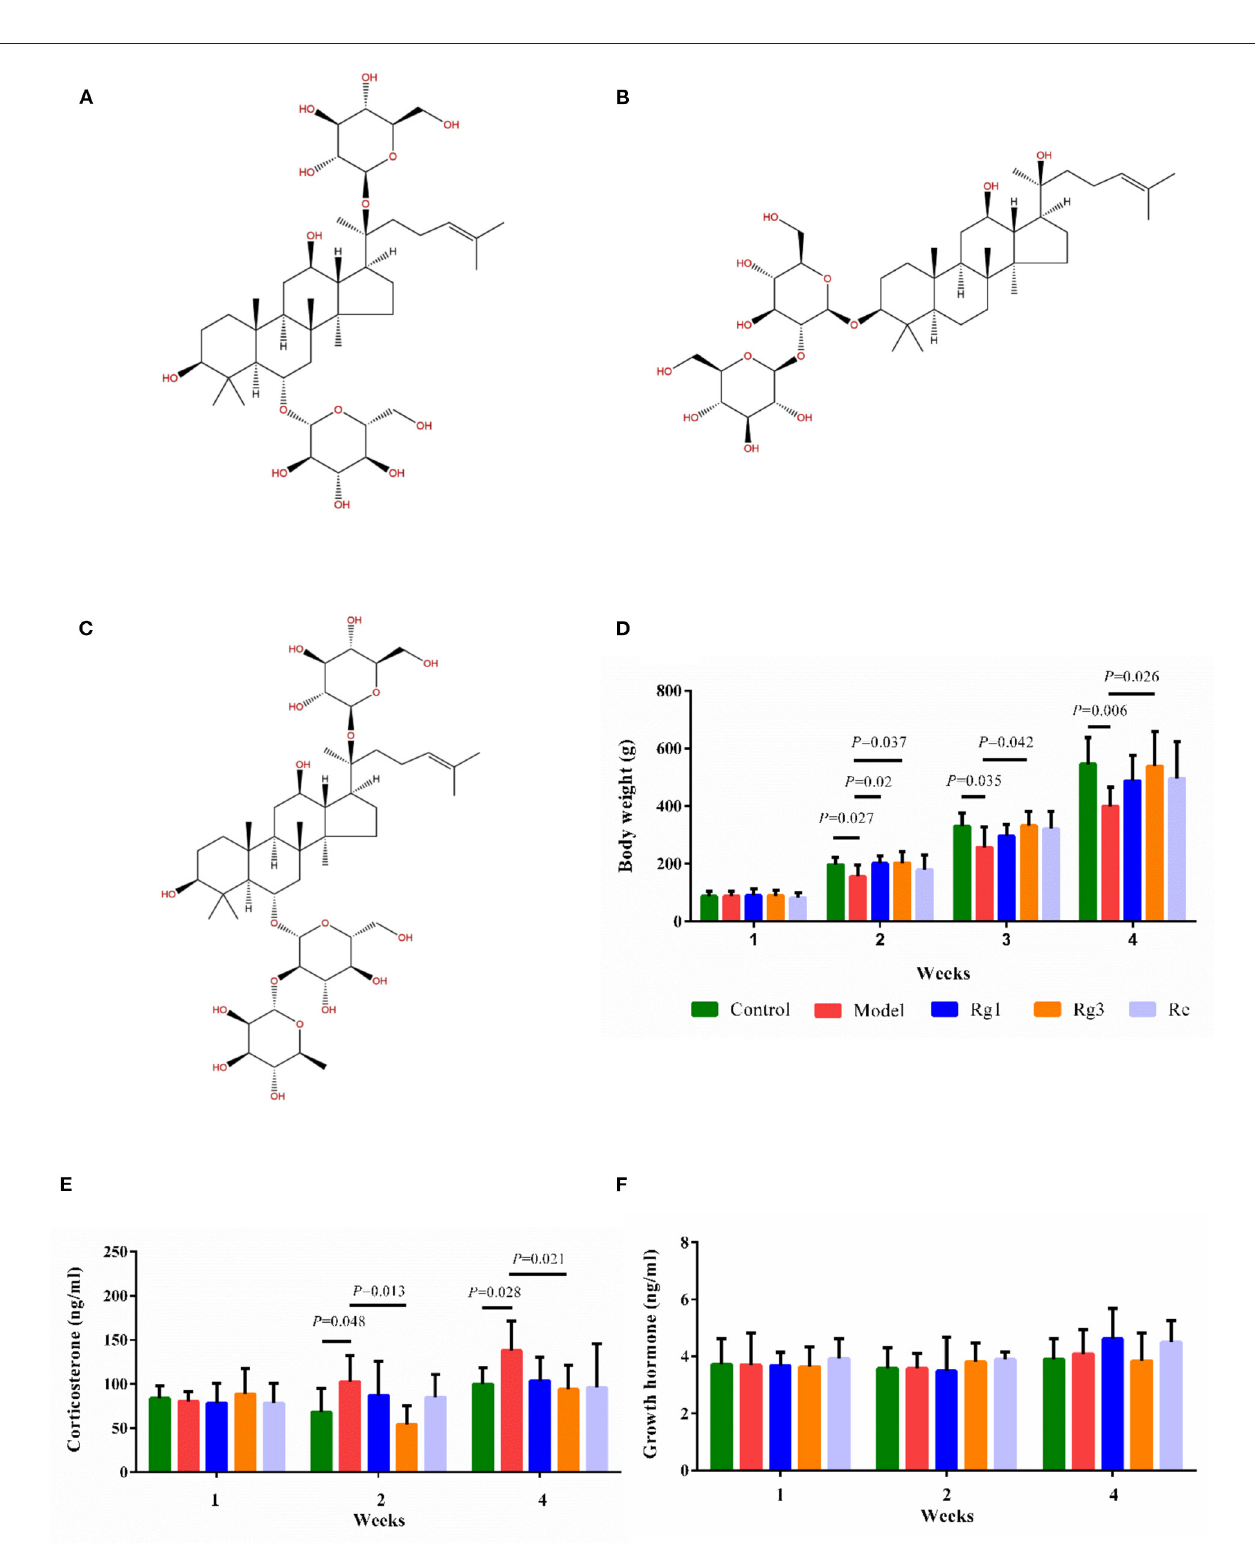
FIGURE 1 | Effect of ginsenosides on growth and stress of broiler chicks. Chemical structure of ginsenoside Rg1 (C42H72O14; molecular weight, 801.024) (A) ; Rg3 (C42H72O13; molecular weight, 785.025) (B) ; Re (C48H82O18; molecular weight, 947.166) (C) . Determination of body weight (D) , serum corticosterone (E) , and serum growth hormone (F) by ELISA. Values are means ± standard error (SE) ( n = 8).